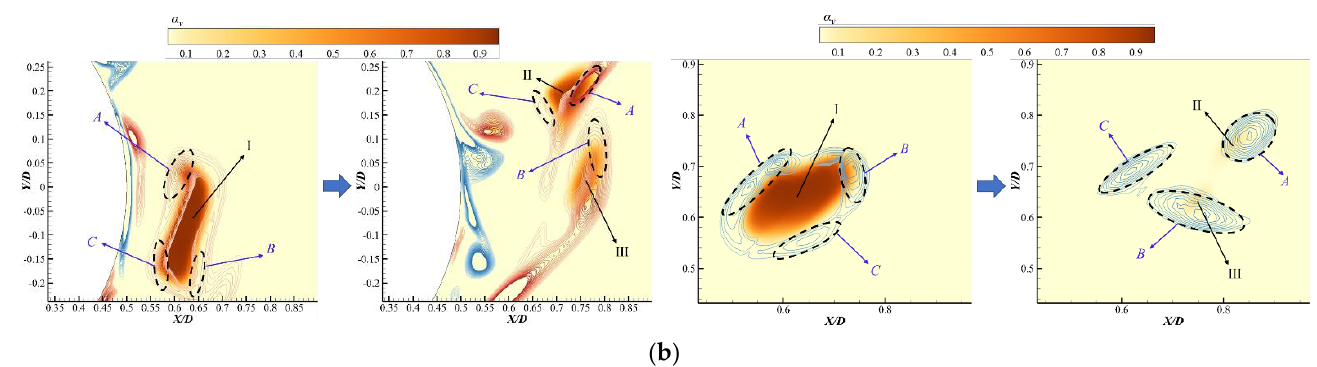
Figure 10. Interactions of vortical evolution and cavitation: ( a ) Merging; ( b ) Splitting.